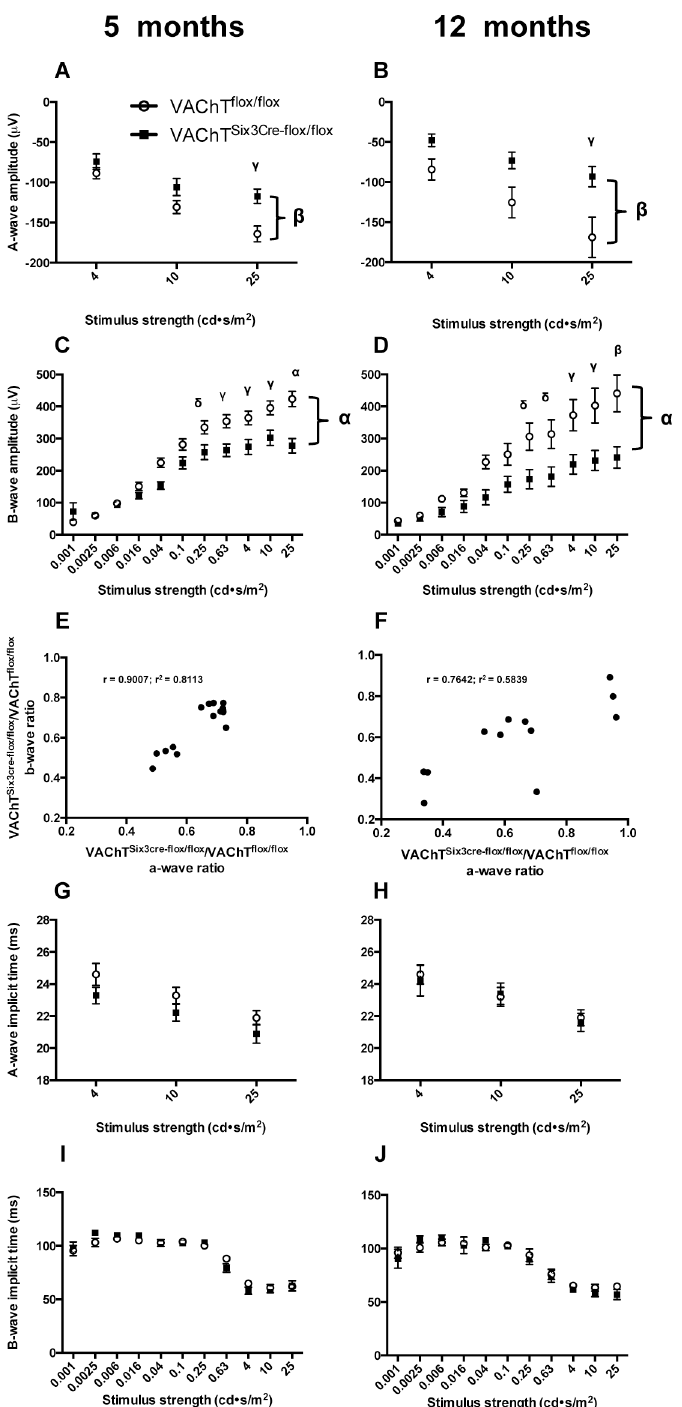
Fig 4. Quantitative assessment of a- and b-waves. Amplitudes of the a-wave (A-B) and b-wave (C-D) are reduced in VAChT Six3-Cre-flox/flox retinas (open circles) relative to littermate controls (VAChT flox/flox , closed squares) at 5 (n = 7 VAChT Six3-Cre-flox/flox and n = 14 littermate control) and 12 months of age (n = 5 VAChT Six3-Cre-flox/flox and n = 5 littermate control). The magnitude of a- and b-wave reduction showed a strong correlation at both 5 (E) and 12 months of age (F). Implicit times of the a-wave (G-H) and b-wave (I-J) are unaffected by the absence of VAChT at either age examined. Values are the mean ± SEM. For all ERG analyses, large symbols that are located to the far right of each graph and connected to the datasets